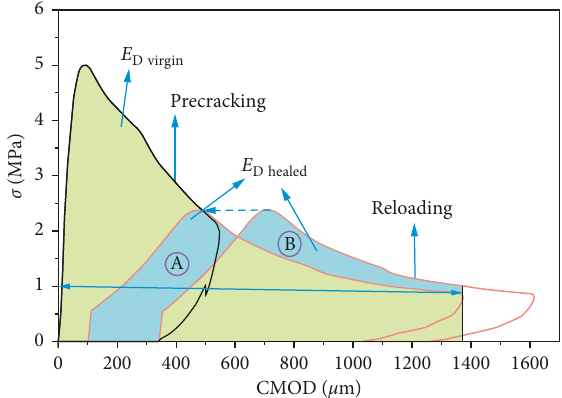
Figure 4: Schematic diagram of a curve of stress ( σ ) versus CMOD after crack healing, which is used for calculating the index of dissipation energy gain